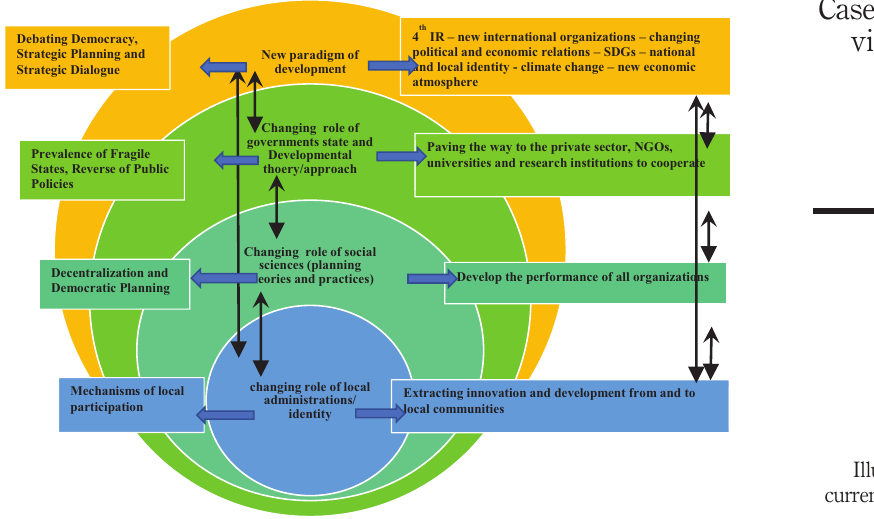
Figure 1. Illustration of